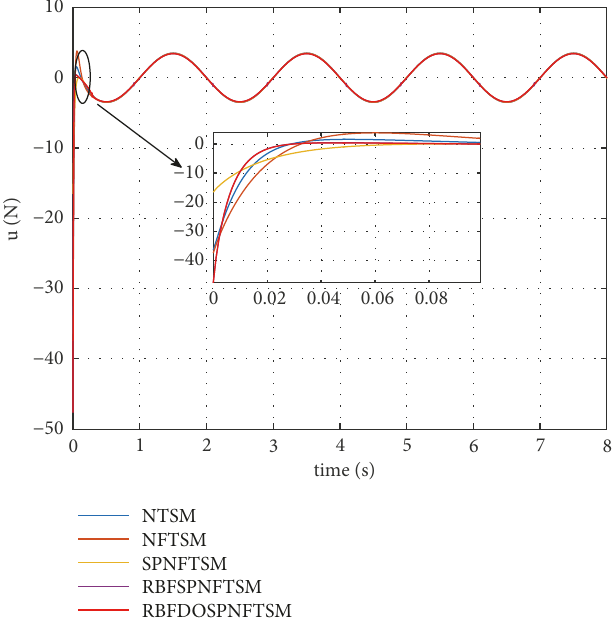
Figure 7: Control input response curve.